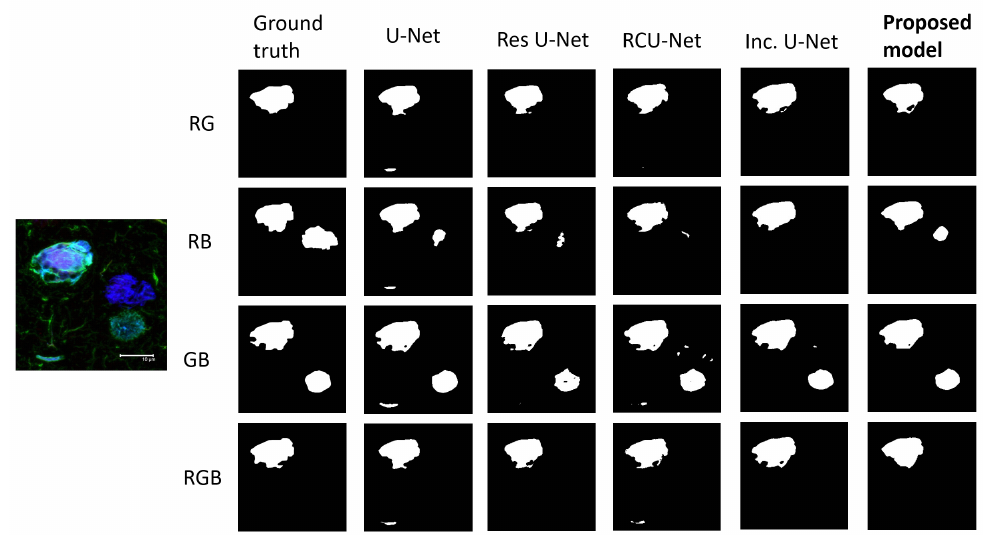
Figure 5. Experimental segmentation results obtained with the different neural network models. Each column represents the outputs of the corresponding model and each row one combination of channels. R: red; G: green; B: blue.